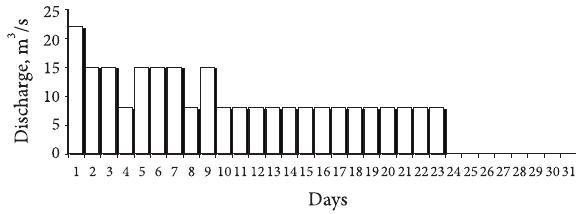
Fig. 9. Release discharges from gates of Goksu dam in the time of flood (March 2004)